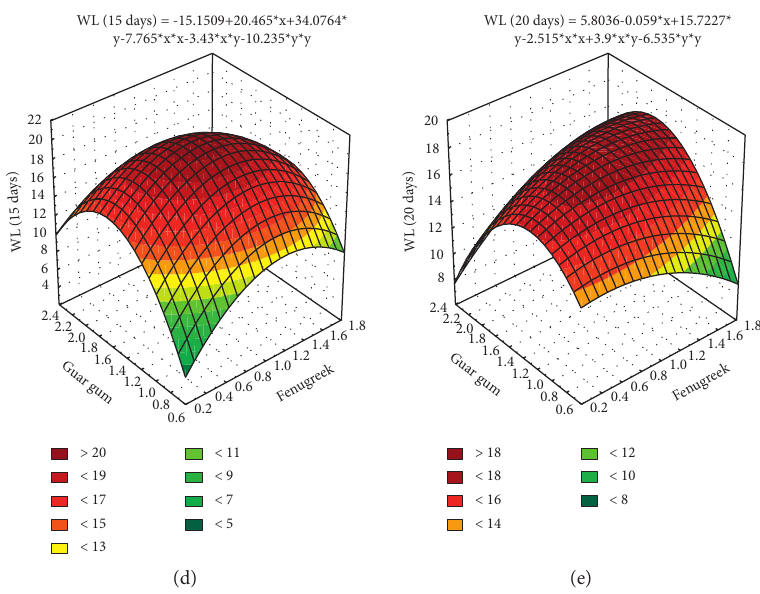
Figure 2: Response surface plot showing the impact of guar galactomannan and fenugreek galactomannan on weight loss of guava fruit during storage. (a) WL (0 days) � 0+0 ∗ x +0 ∗ y +0 ∗ x ∗ x +0 ∗ x ∗ y+0 ∗ y ∗ y . (b) WL (5 days) � -8.506 +22.3118 ∗ x +25.3257 ∗ y − 10.6275 ∗ x ∗ x − 0.19 ∗ x ∗ y − 8.2275 ∗ y ∗ y . (c) WL (10 days) � 0.5276+2.252 ∗ x +17.5202 ∗ y − 1.35 ∗ x ∗ x +0.47 ∗ x ∗ y − 5.94 ∗ y ∗ y . (d) WL (15 days) � -15.1509+20.465 ∗ x +34.0764 ∗ y − 7.765 ∗ x ∗ x − 3.43 ∗ x ∗ y − 10.235 ∗ y ∗ y . (e) WL (20 days) � 5.8036–0.059 ∗ x + 15.7227 ∗ y − 2.515 ∗ x ∗ x + 3.9 ∗ x ∗ y − 6.535 ∗ y ∗ y .